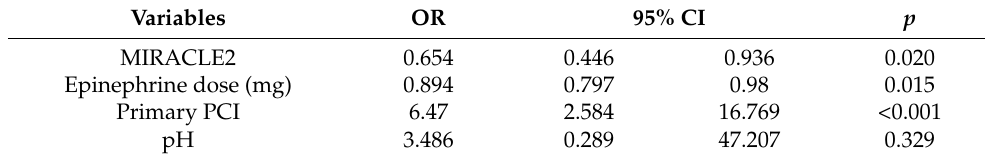
Table 2. Adjusted odds ratios of MIRACLE2 for favorable neurologic